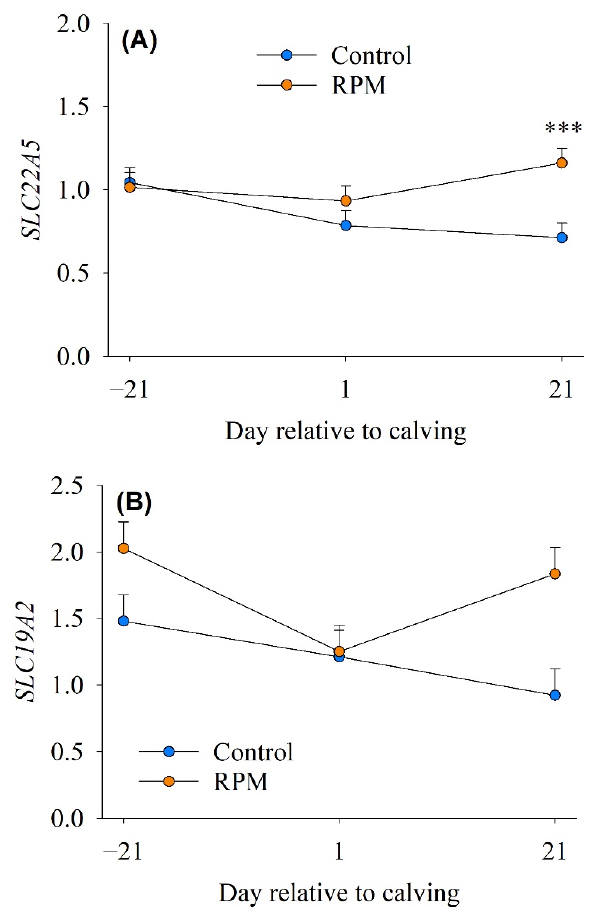
Figure 2. mRNA abundance of genes associated with carnitine and vitamin transport in skeletal muscle of dairy cows ( n = 10/diet) fed a basal control diet or the basal diet plus ethyl-cellulose rumen-protected methionine (RPM) from -21 to 21 day of calving. ( Panel A ), solute carrier family 22 member 5 ( SLC22A5 ); ( Panel B ), solute carrier family 19 member 2 ( SLC19A2 ). Error bars represent SEM. *** p < 0.001.